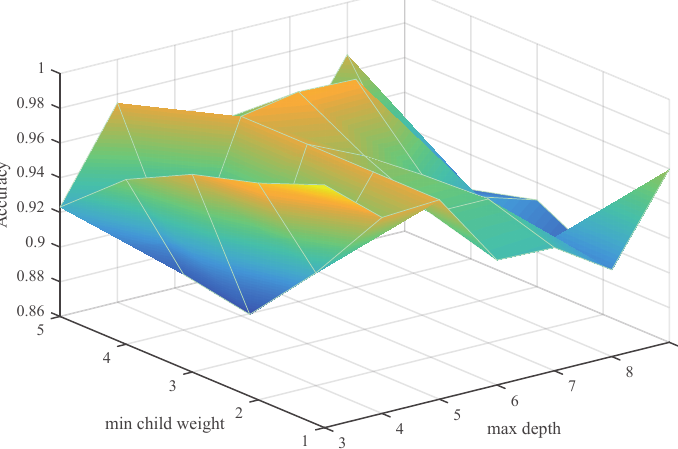
Figure 9. The relationship between recognition accuracy and max depth, min child